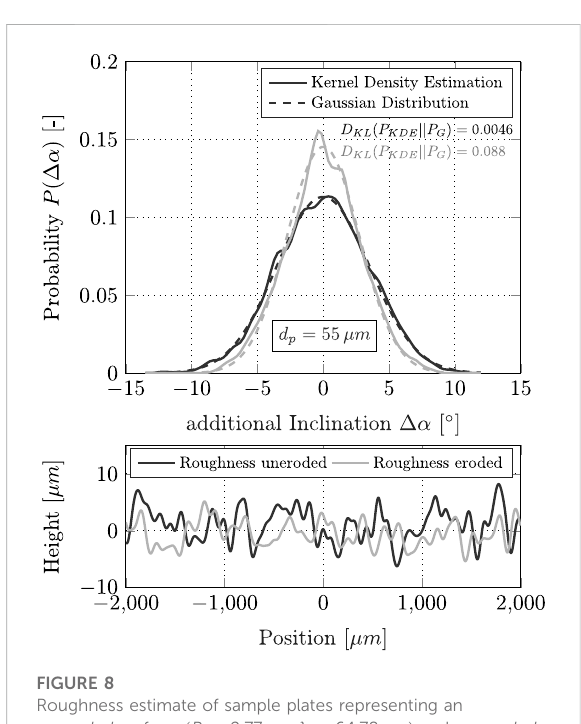
FIGURE 8 Roughness estimate of sample plates representing